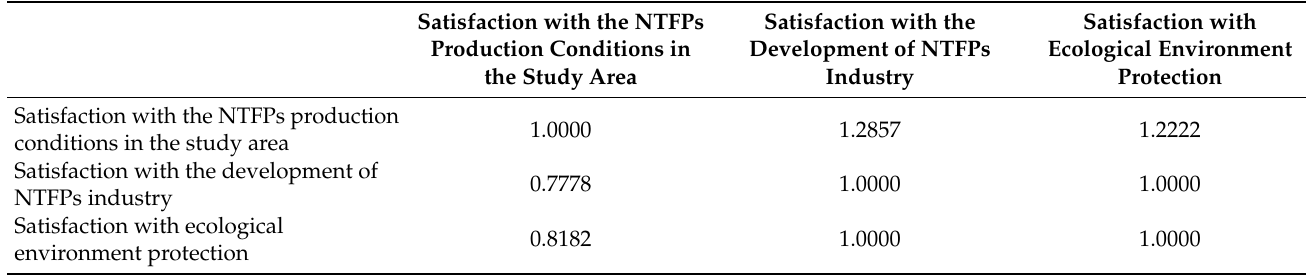
Table A12. C8–D: Judgement matrix of the satisfaction with poverty alleviation